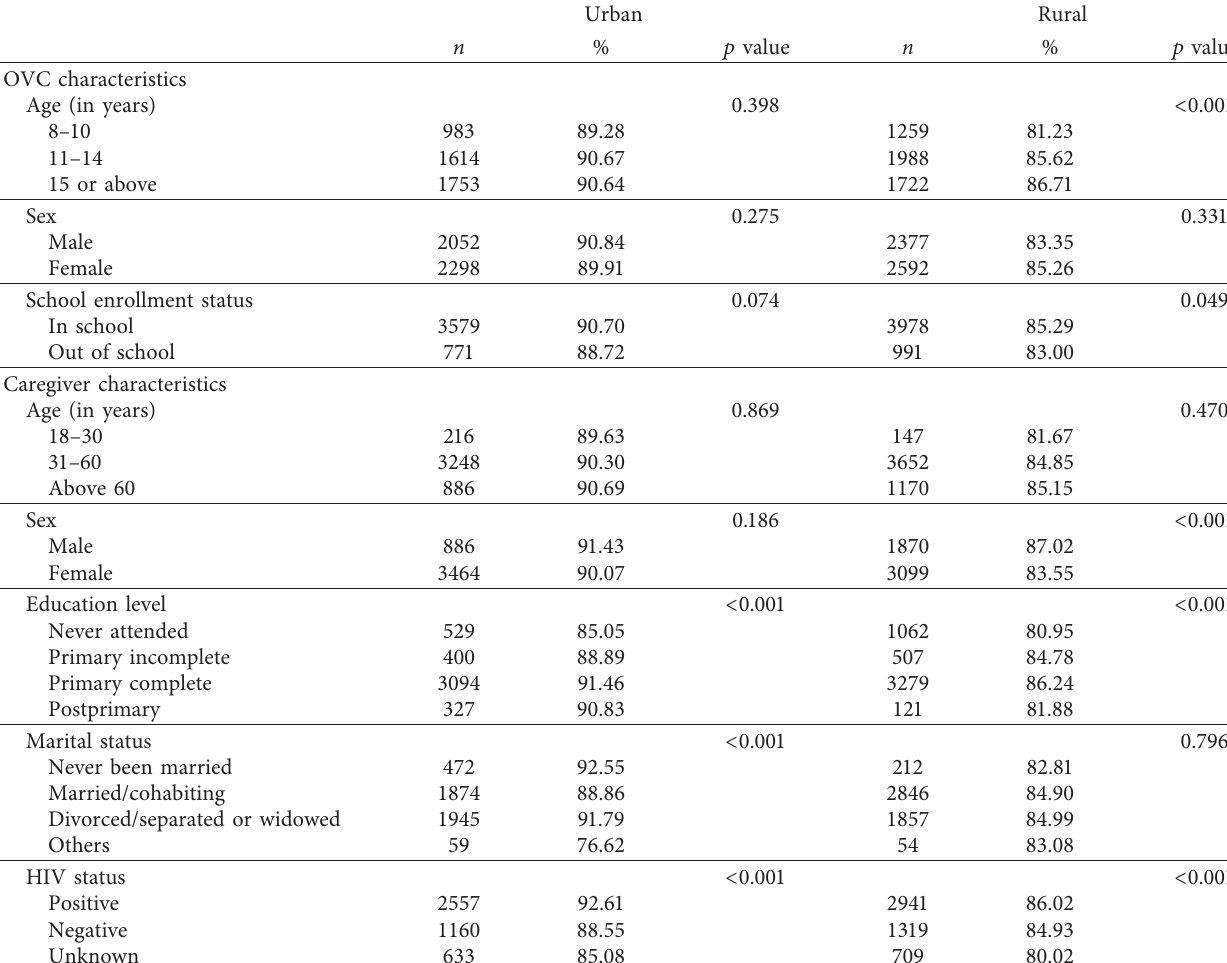
Table 2: Differences in HIV status disclosure by location and OVC and caregiver